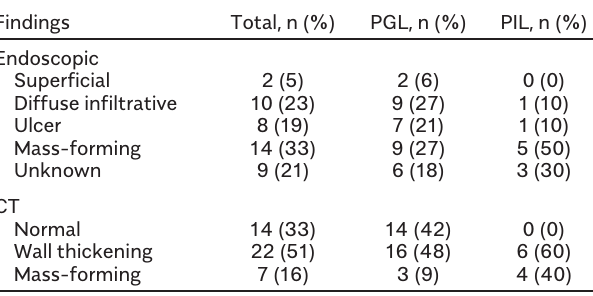
Table 2. Endoscopy and Computed Tomography Findings of Patients with Primary Gastrointestinal Lymphoma